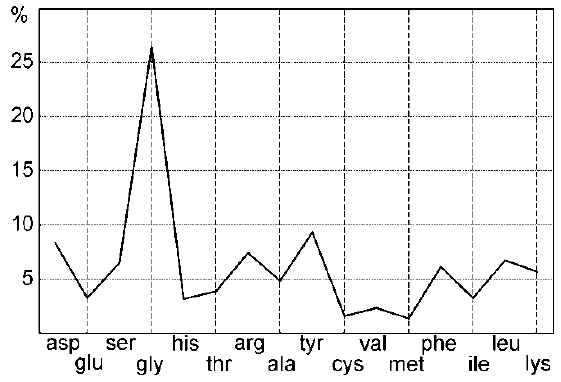
Figure 7. Aminoacid composition of the insoluble matrix (IOM) of Pinna nobilis , obtained using a decalcification process, showing the high glycine content.